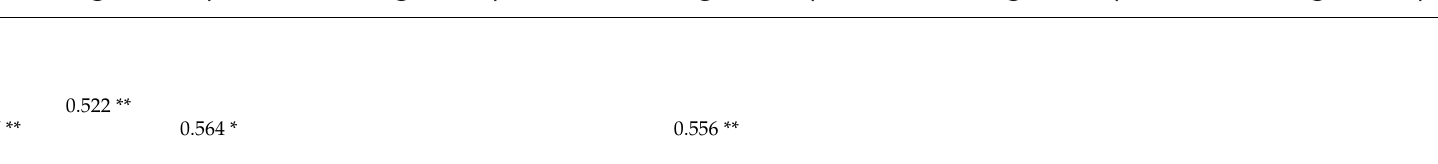
Figure 4. Correlations between tissues for THg concentration in ABFT. The solid line indicates a p-value < 0.01, and a dashed line indicates a p-value < 0.05. The thickness of the line represents the strength of the relationship.